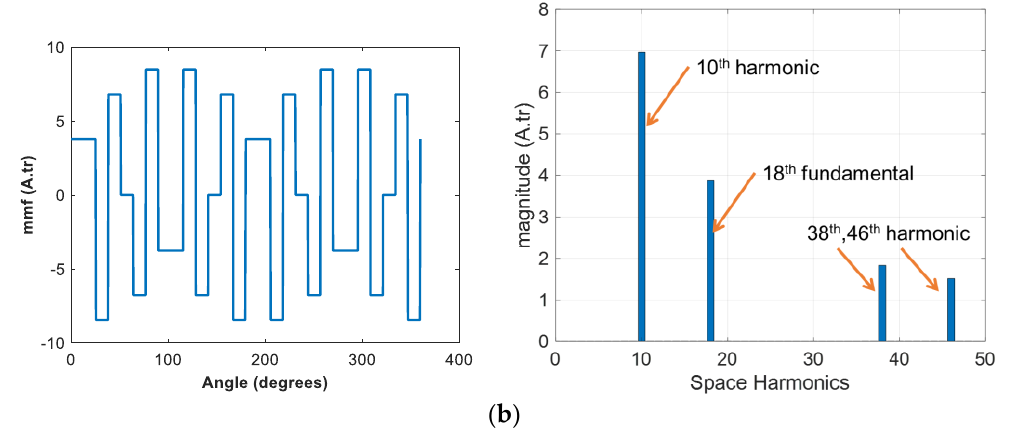
Figure 4. MMF harmonic spectrum of seven-phase AFM with fundamental current and third harmonic current: ( a ) fundamental harmonic; ( b ) third harmonic.